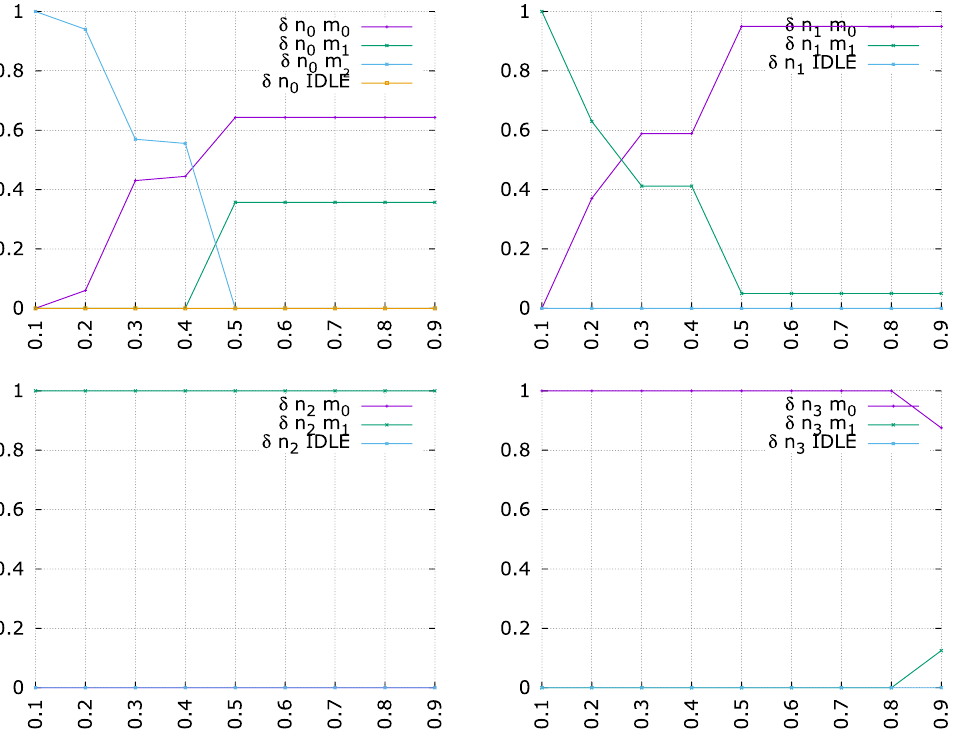
Figure 6. How moving the ratio between attacker profiles (gamma) affects the defender